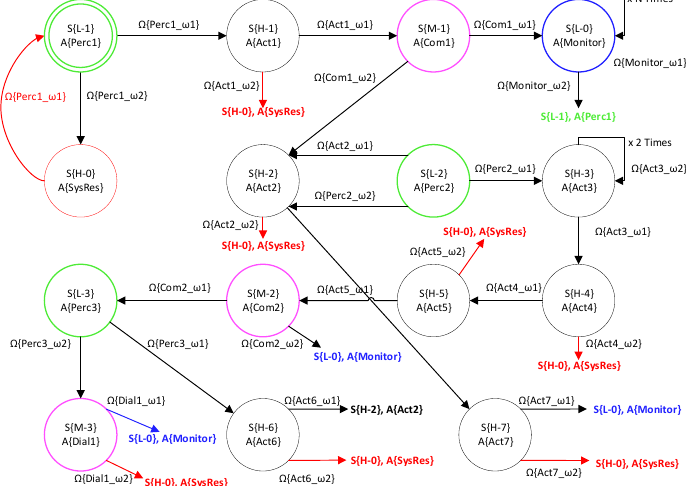
Figure 12. The POMDP policy graph of the robot decision maker as a finite-state controller. The graph comprises a subset of all the identified states that can be aroused during the medication assistance scenario; however, it exhibits the majority of the Actions A which correspond to the manipulation and perception skills described in the previous sections. The states grouped with the same colour indicate that they belong to the same LoRA convention during the definition of the